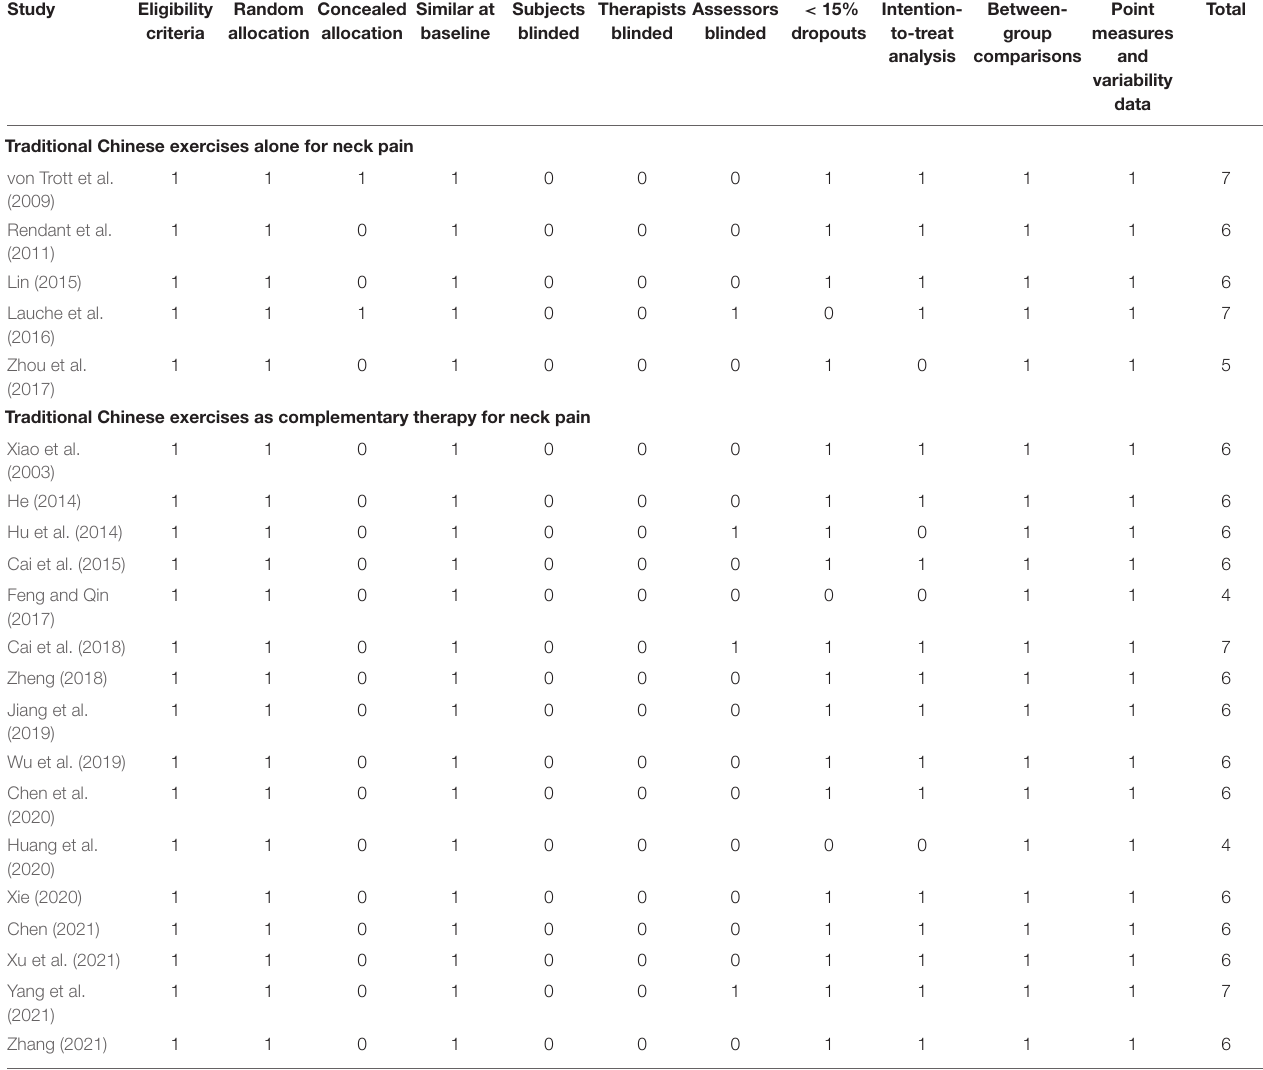
TABLE 2 | PEDro scale of quality for the included studies.